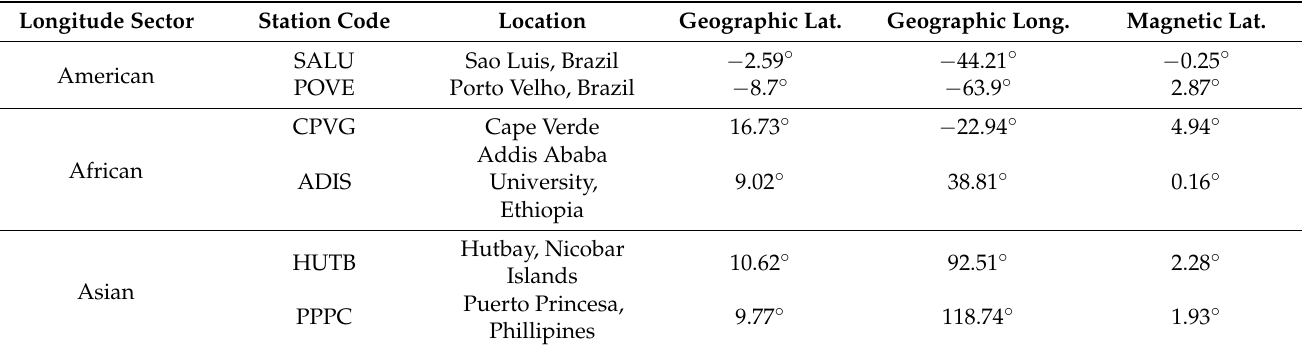
Table 1. The geographic coordinates and magnetic latitude of the GPS stations in American, African, and Asian longitude